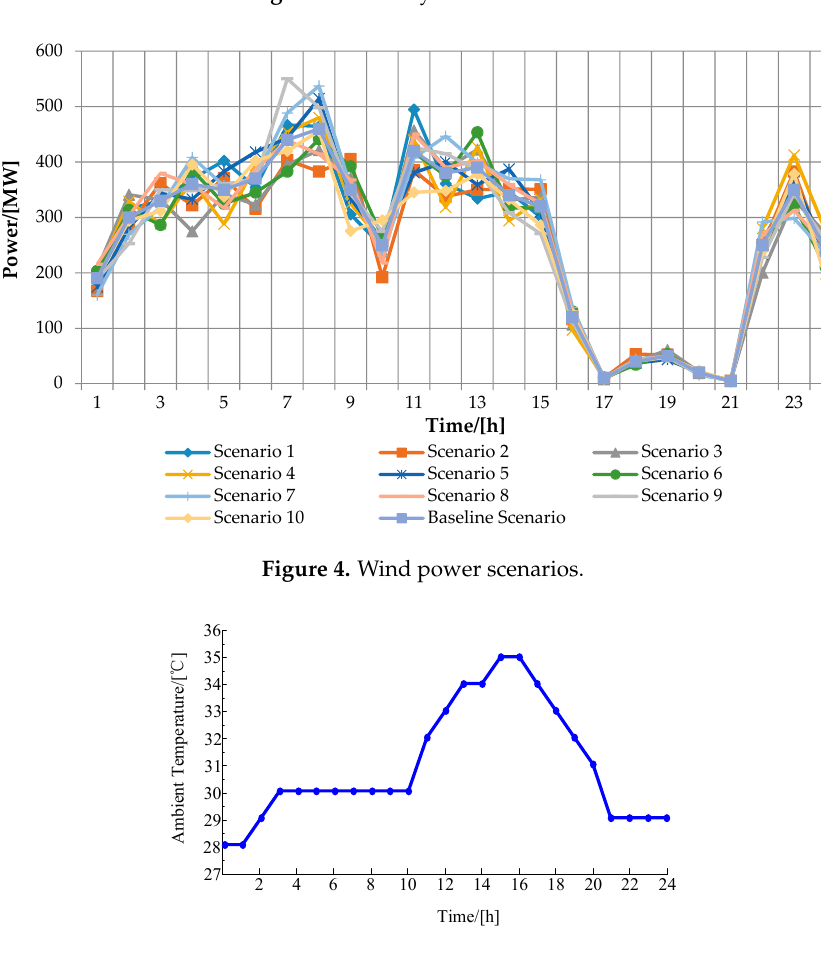
Figure 3. Initial system load curve.